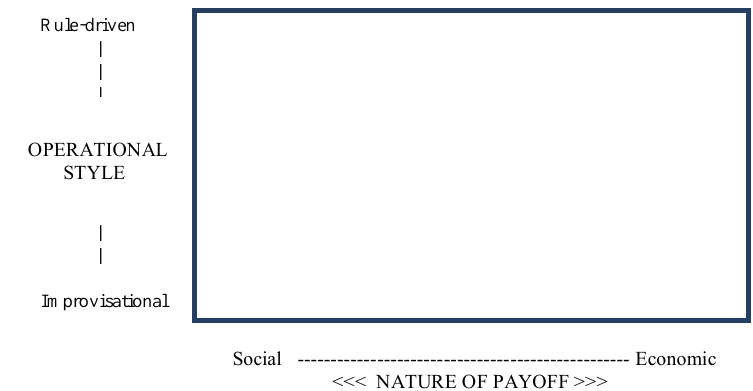
Figure 3. Positioning a work system using nature of payoff and operational